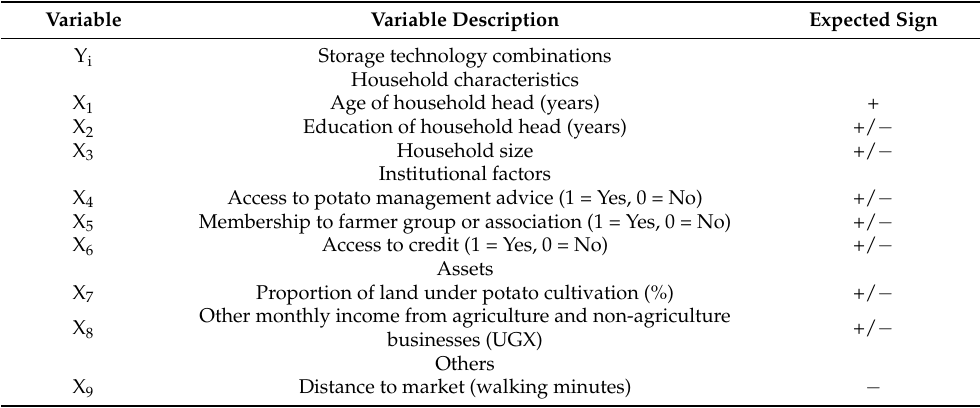
Table 2. Variables used in the multinomial probit model and their hypothesized signs.